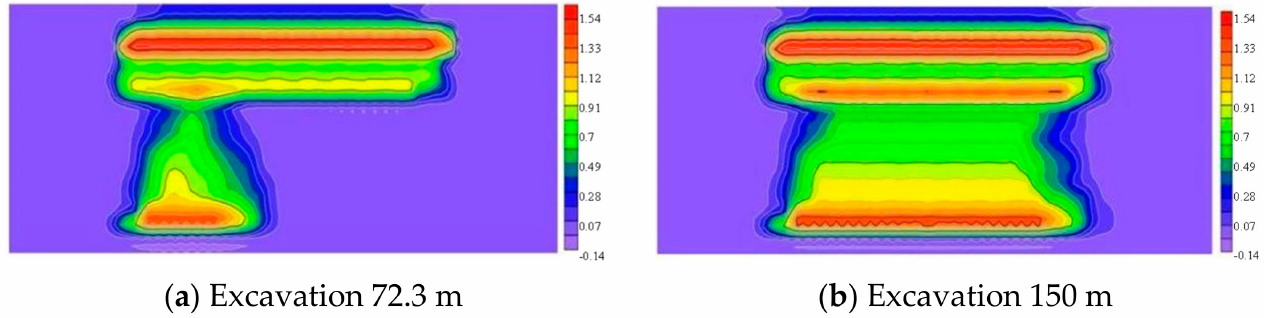
Figure 11. Evolution characteristics of the displacement field of the strata during the mining of the 9# coal